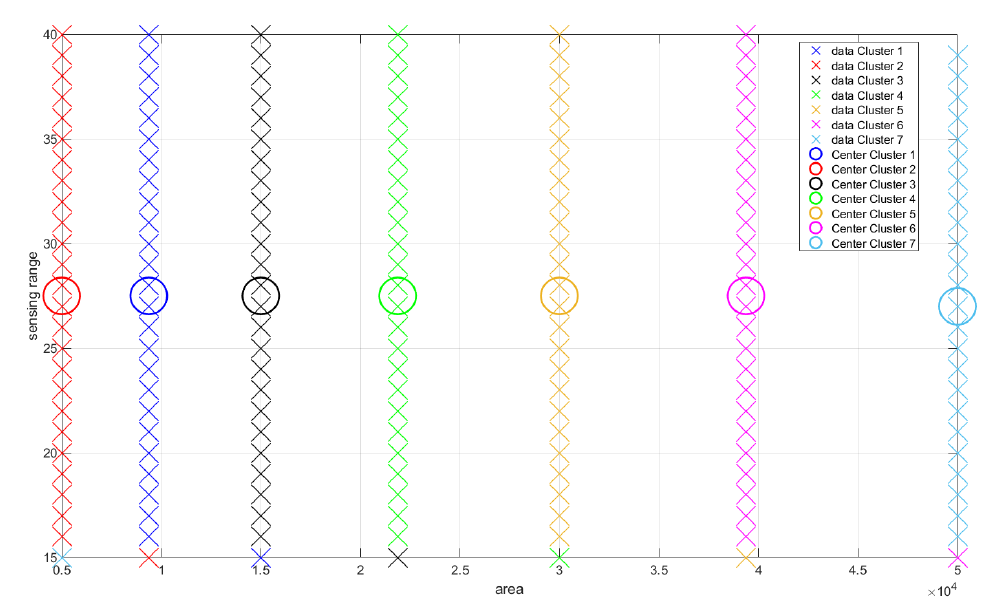
Figure 10. Final result of data fuzzification (relation area versus sensing